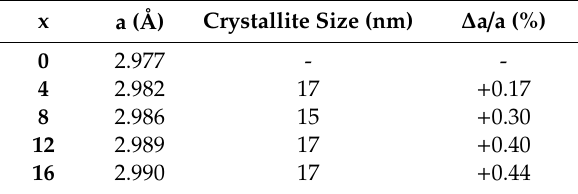
Table 1. Cell parameters and crystallites size of TiFe + x wt.% Hf (x = 0, 4, 8, 12, and 16). The uncertainty on the lattice parameters and crystallite sizes were identical for all composition and respectively 0.002 Å and 1 nm.